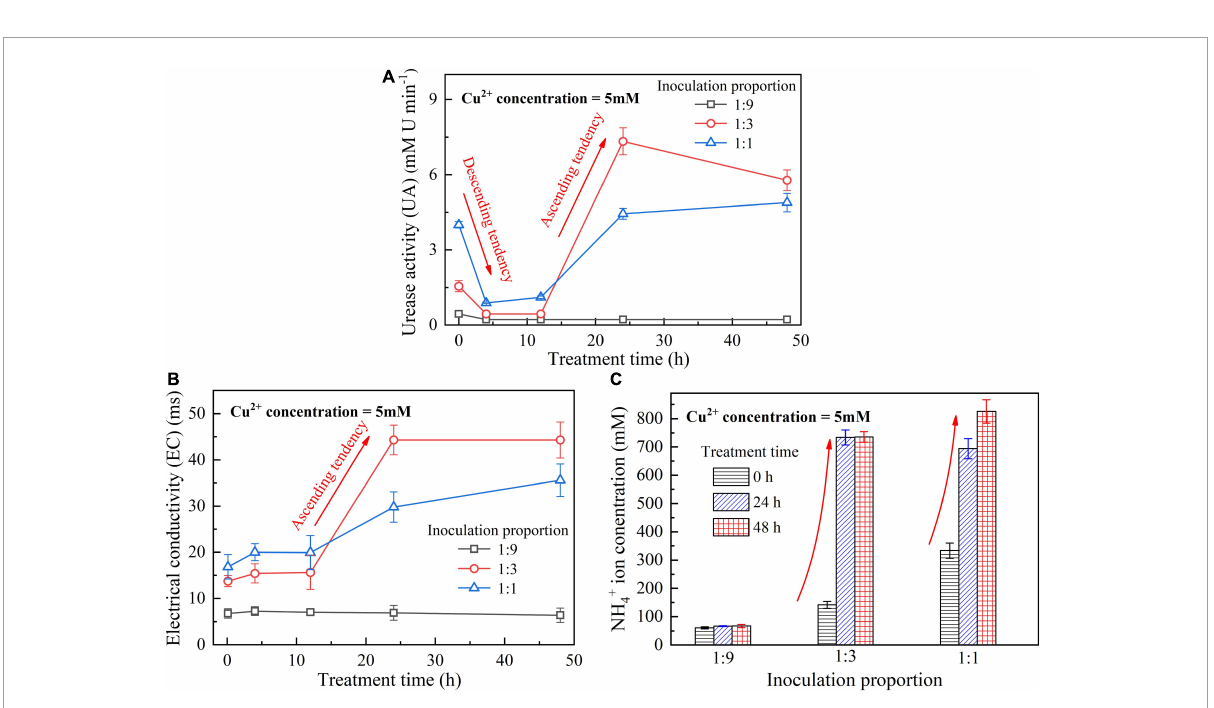
FIGURE3 (A) UA vs. treatment time relationship, (B) EC vs. treatment time relationship, and (C) NH 4 + vs. treatment time relationship when subjected to Cu 2 + concentration at 5